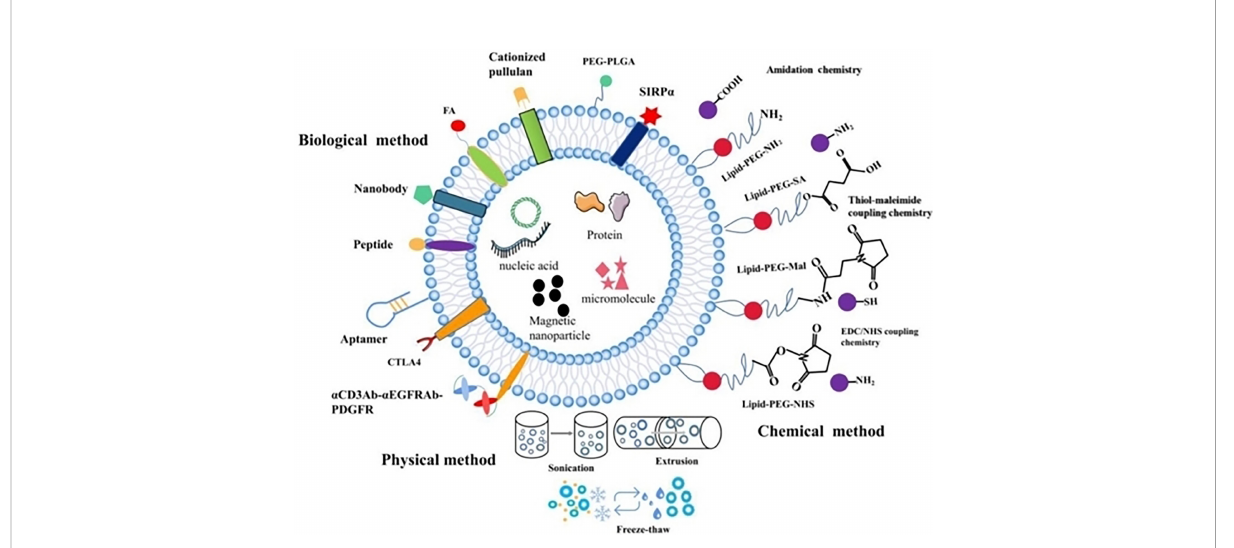
FIGURE 5 Exosomal surface engineering for precision targeting in cancer nanotherapeutics. Reproduced with permission from Ref (86). Copyright 2021,